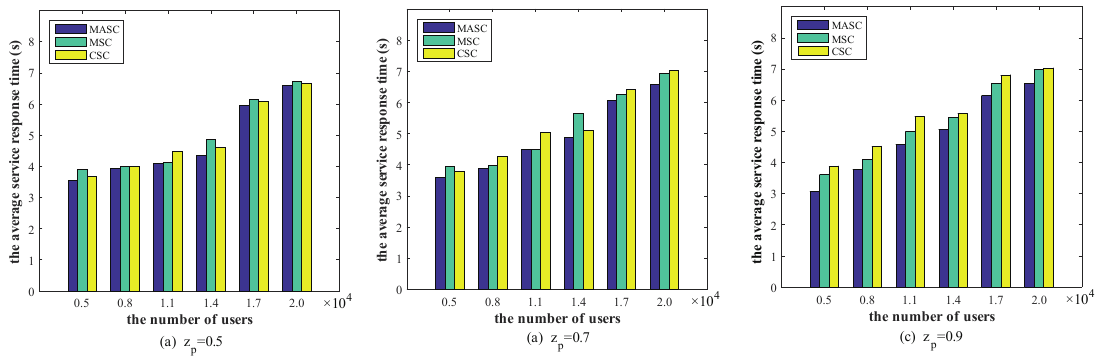
Figure 10. Performance comparison under different user